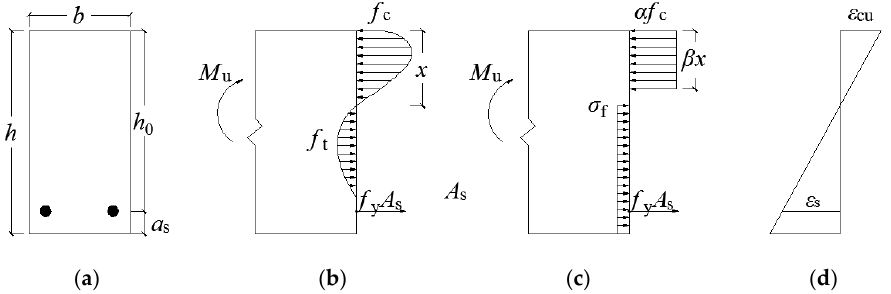
Figure 9. Stress and strain distributions of the strengthened beams under bending failure: ( a ) cross section; ( b ) stress distribution; ( c ) equivalent rectangular compressive stress distribution; ( d ) strain distribution.